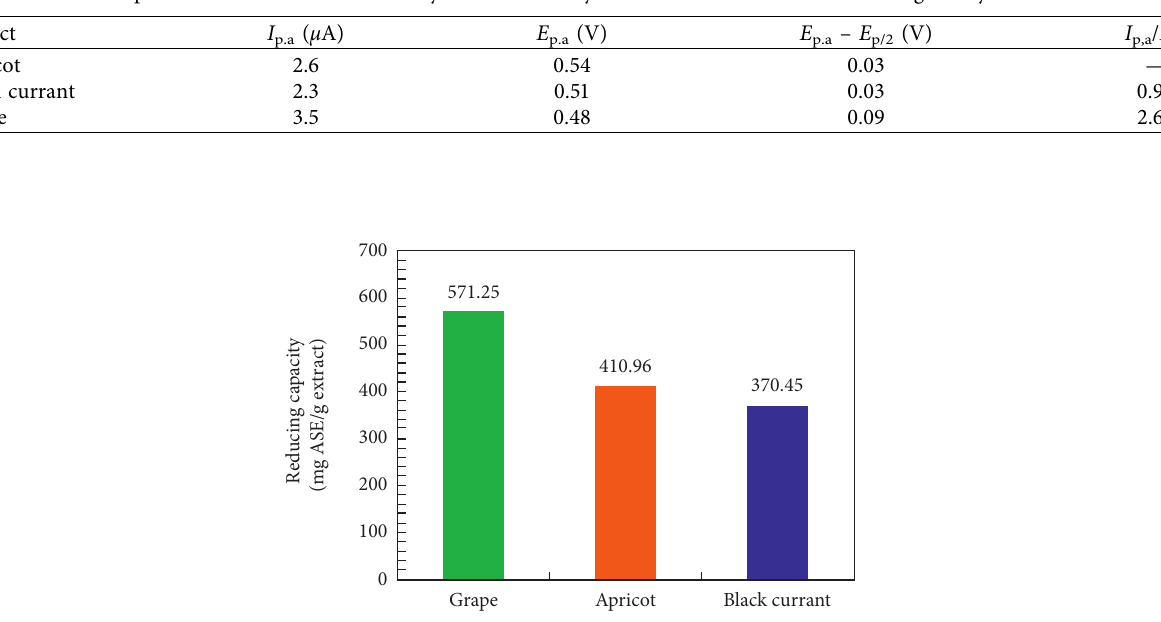
Figure 6: Reducing power of the aqueous black currant, apricot, and grape pomace extracts evaluated by the phosphomolybdenum